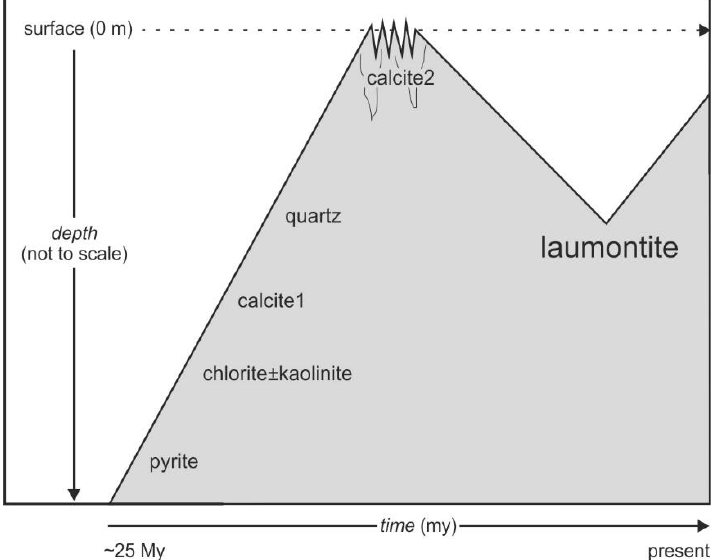
Figure 3. Exhumation and subsidence history of the study area revealed by Juhász et al. [ 22] and Schubert et al. [ 18] .